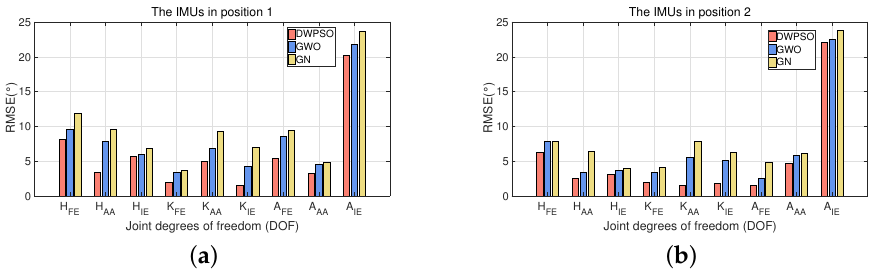
Figure 11. The RMSE ( ◦ ) comparison of three algorithms when IMUs on subject 3 were bound in two positions. ( a ) The IMUs in position 1; ( b ) the IMUs in position 2.